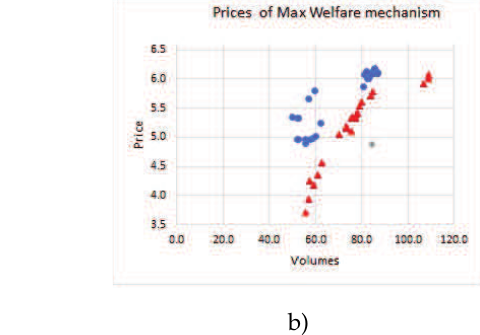
Figure 7. The optimal mechanism pricing. The optimal load (a) and prices (b) .